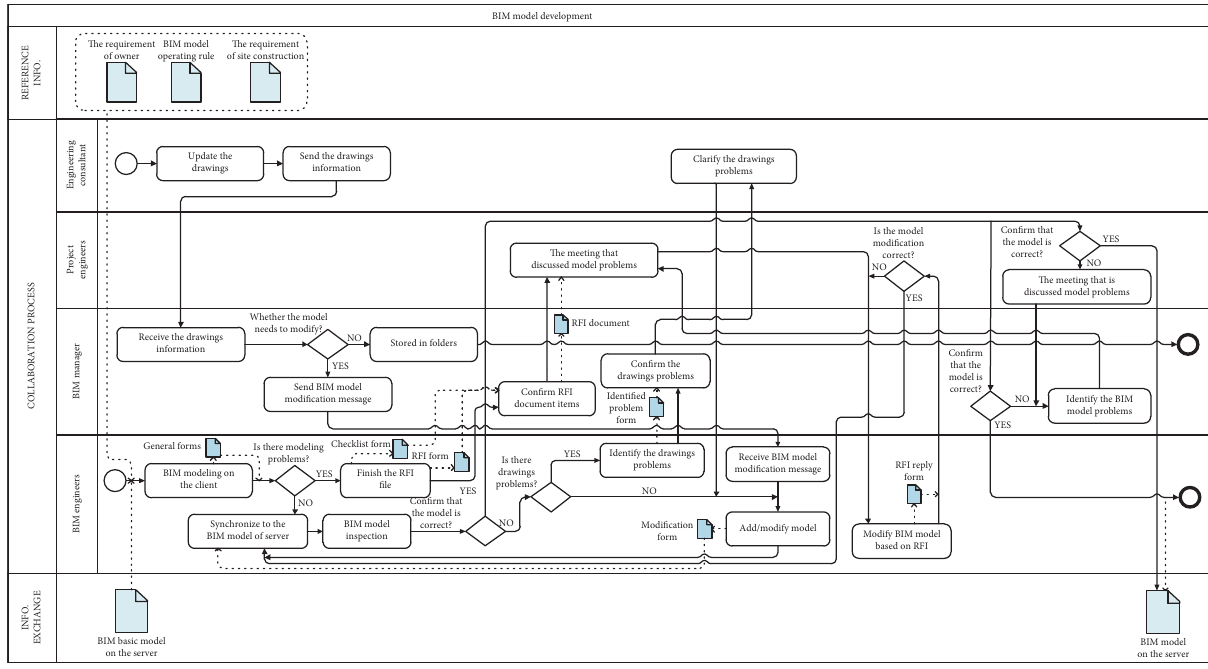
Figure 3: The proposed main management flowchart for